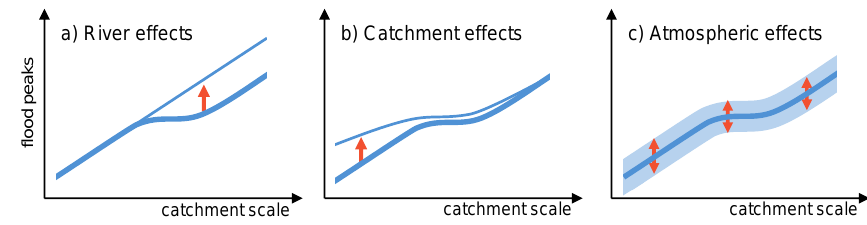
Figure 1. Hypothesised impact of three types of drivers on relative flood peaks as a function of catchment scale (based on Blöschl et al., 2007). (a) River: removing floodplain storage. (b) Catchment: land use change such as urbanisation, (c) atmosphere: climate change such as changes in rainfall characteristics. The thin line and the red arrows illustrate the effect of one of the three groups of drivers on the flood peak